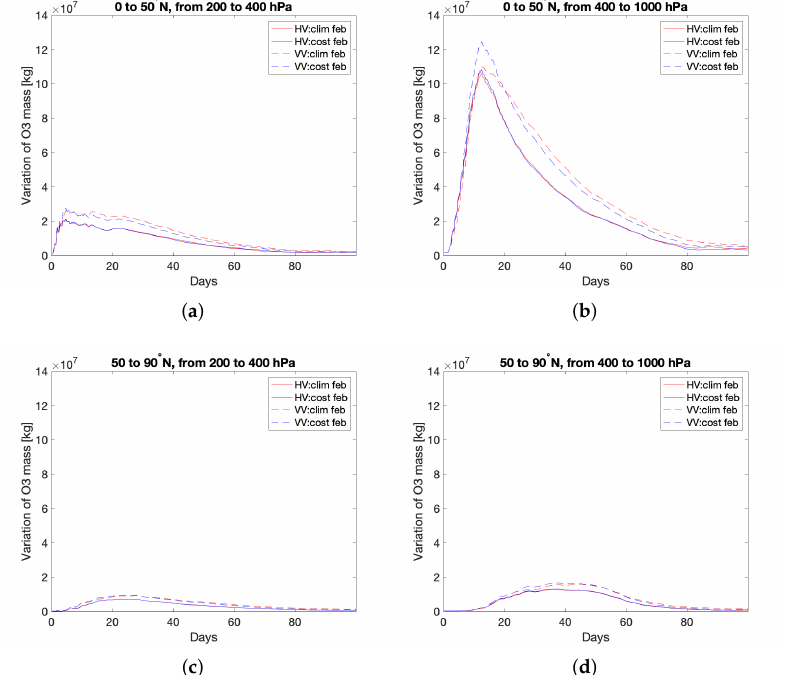
Figure 16. Time series of O 3 atf mass (kg) in specific regions from chemistry–climate simulations starting on 1 February 2016. The red and blue lines indicate the climate-optimised and cost-optimised cases, respectively, and the panel titles in ( a – d ) indicate the investigated